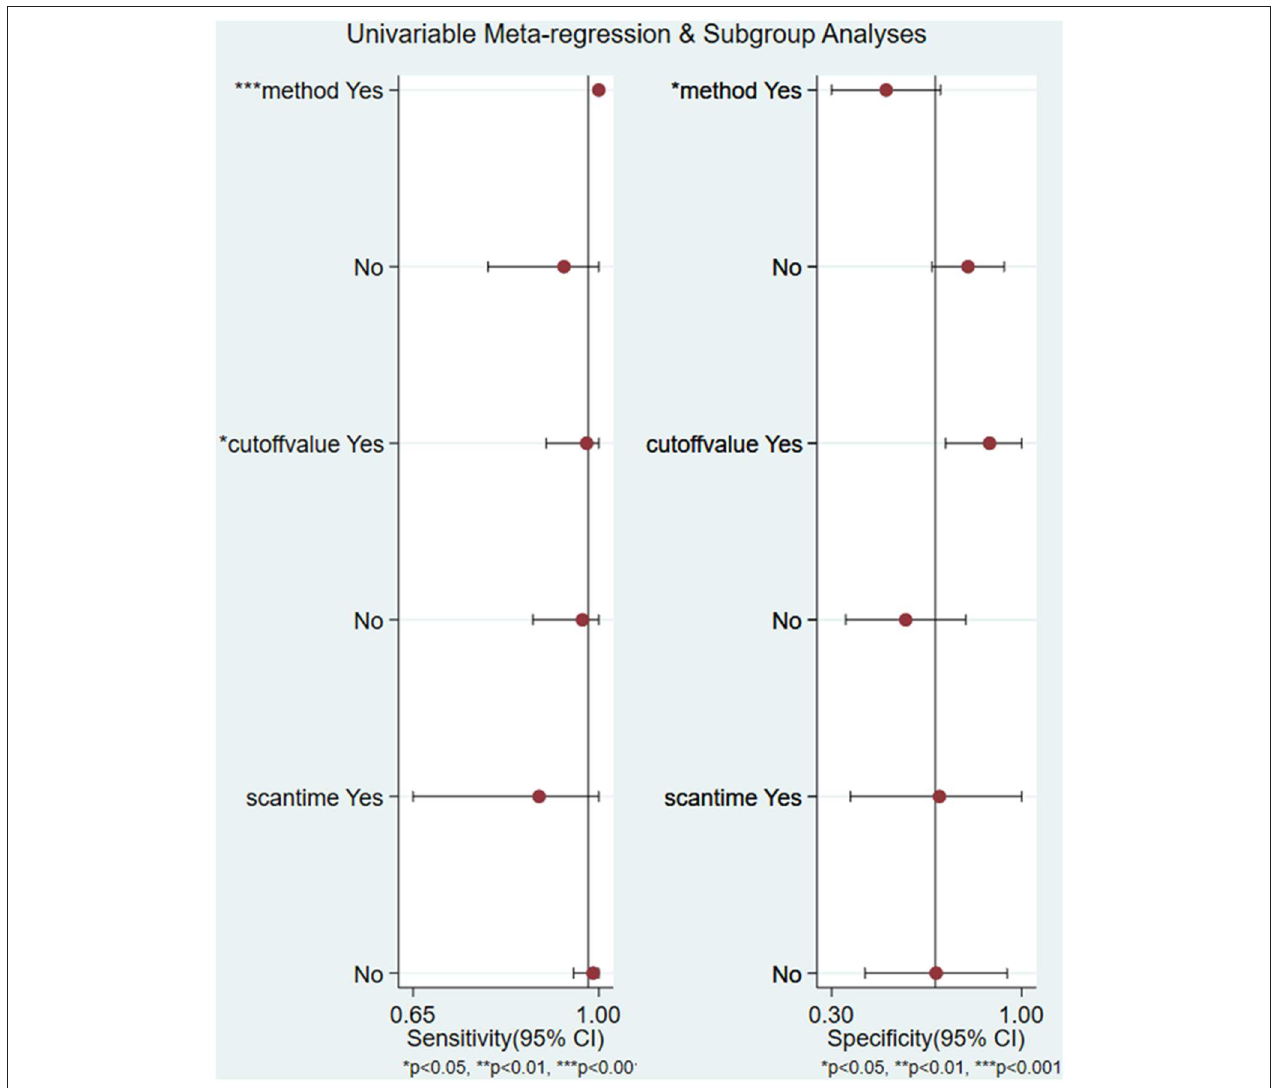
FIGURE 4 | Univariate regression analysis and subgroup analysis for the uptake change ratio of 99m Tc-MIBI scintigraphy in preoperatively assessing the response of osteosarcoma patients to neoadjuvant